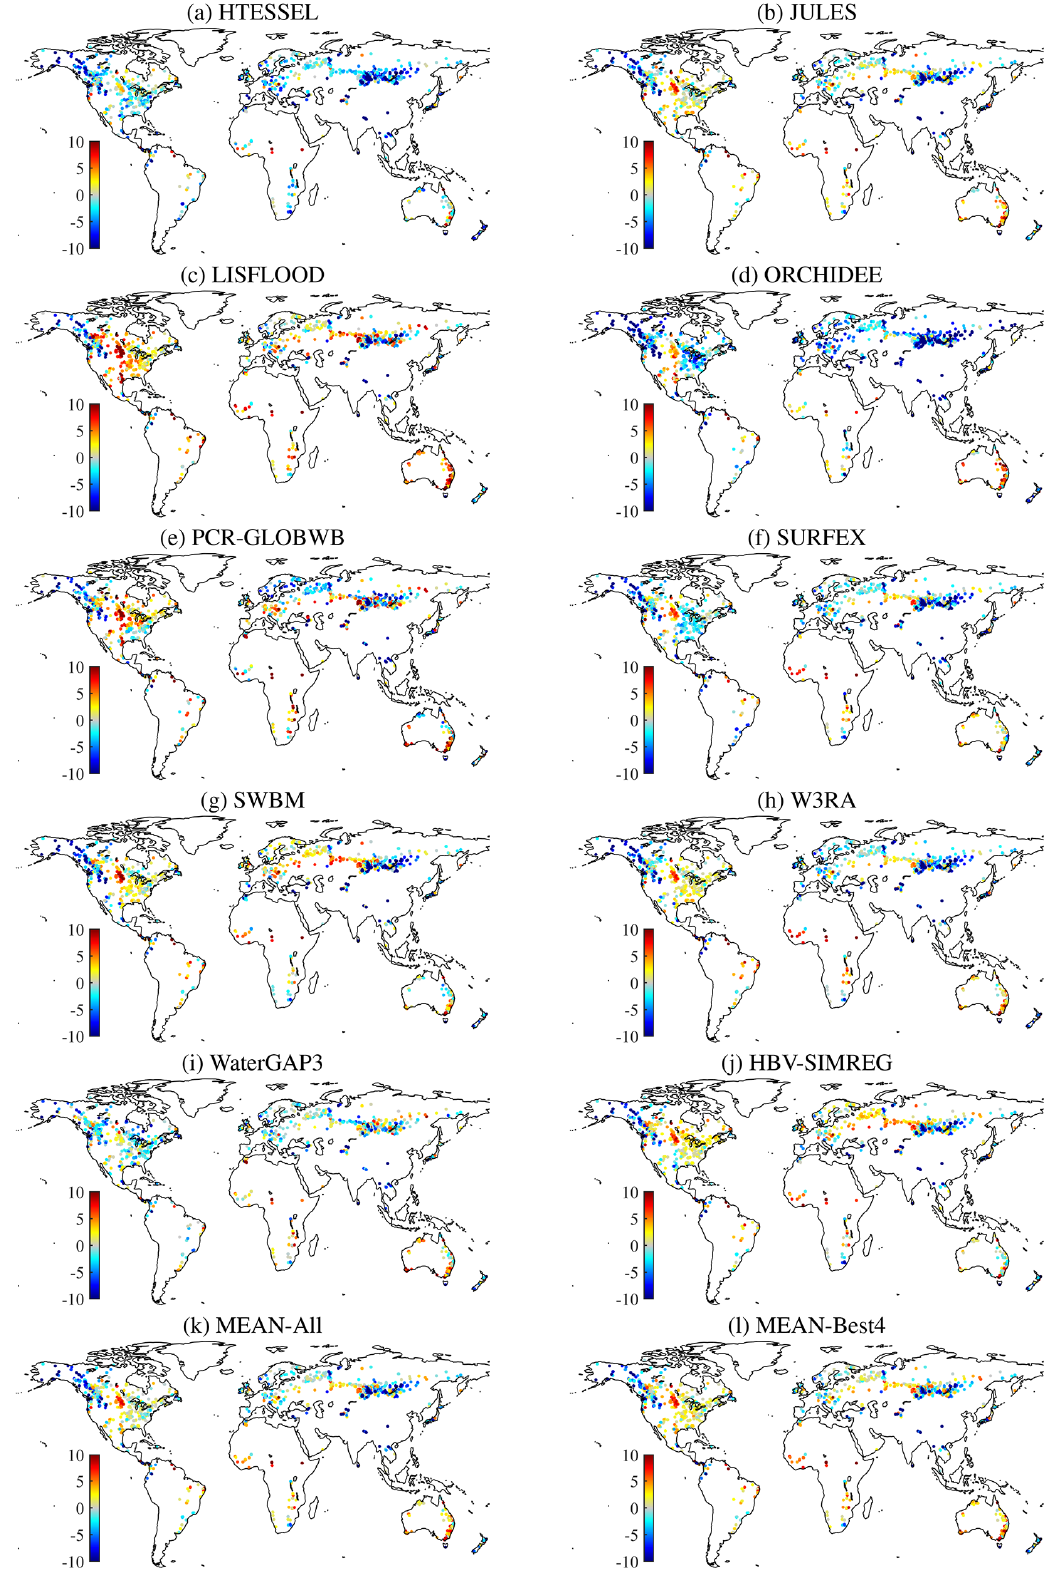
p mm yr − 1 ) for the catchments. Each data